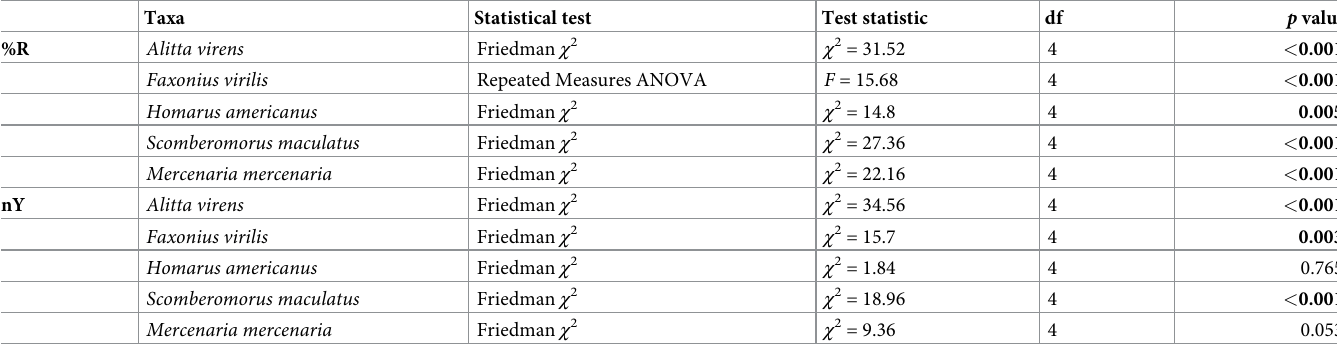
Table 1. Summary of statistical model results.